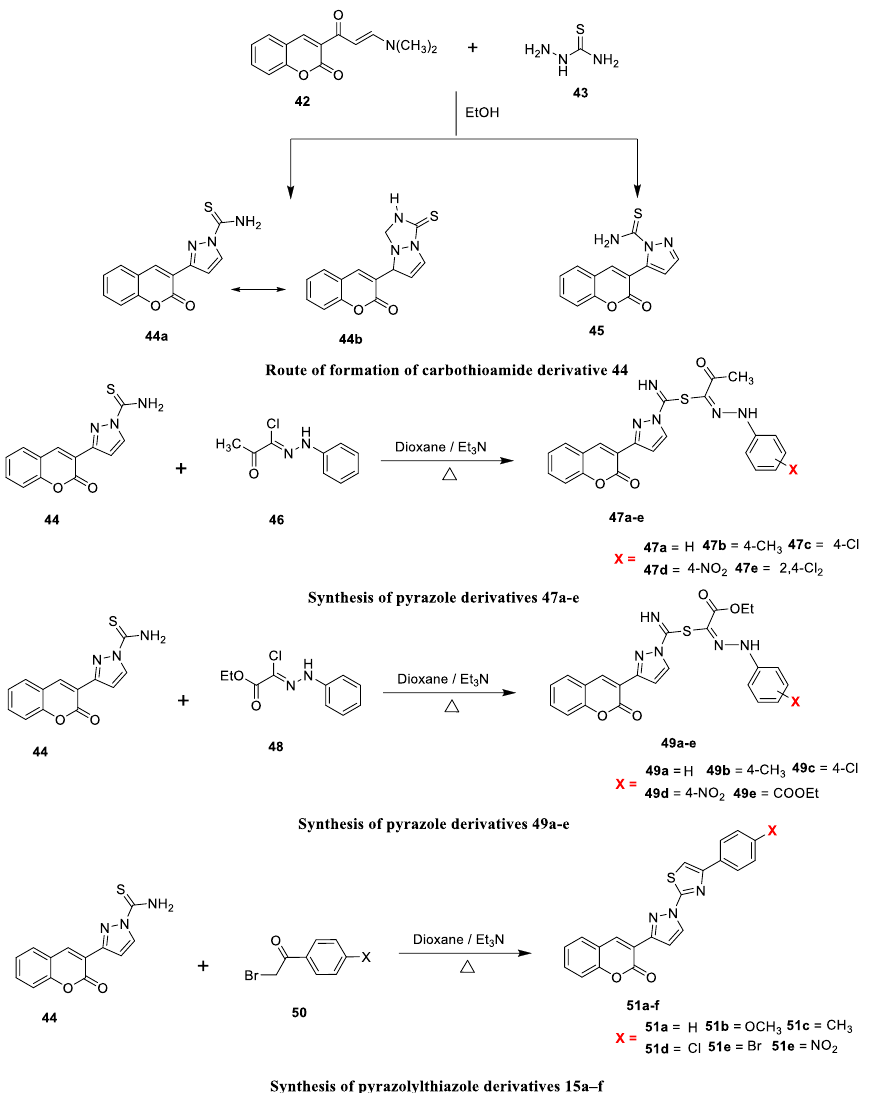
Scheme 6. Outline for the synthesis of the chromenyl – pyrazoles candidates. Reproduced and adapted with permission from ref. 22. Copyright 2020, John Wiley and Sons.